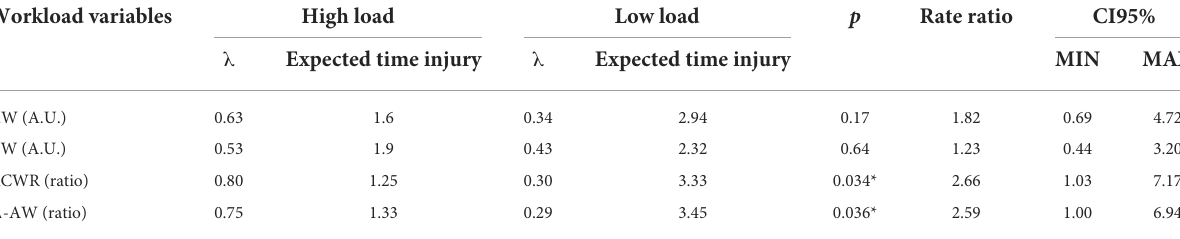
TABLE 4 Relationship between injuries and different levels of load to find the expected time until new injuries. Workload variables